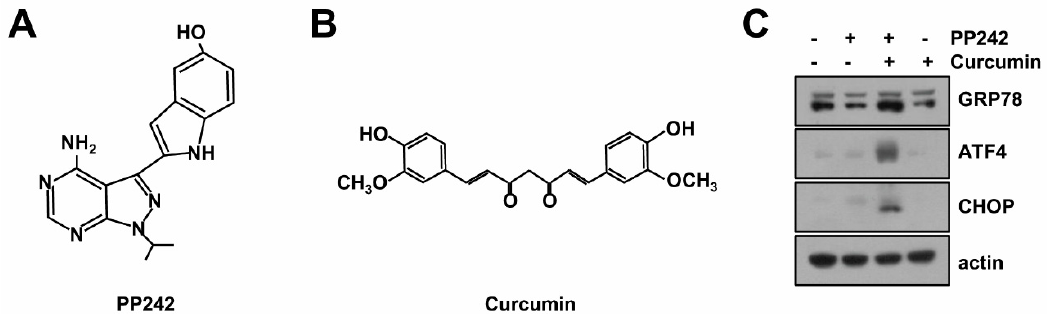
Figure 1. Effects of combined PP242 and curcumin treatment on expression of ER stress marker proteins. Structures of PP242 ( A ) and curcumin ( B ). ( C ) Human renal carcinoma Caki cells were treated with 0.5 µ M PP242 in the presence or absence of 20 µ M curcumin for 9 h. The protein levels of GRP78, ATF4, CHOP and actin were determined by western blotting. The level of actin was used as a loading control.